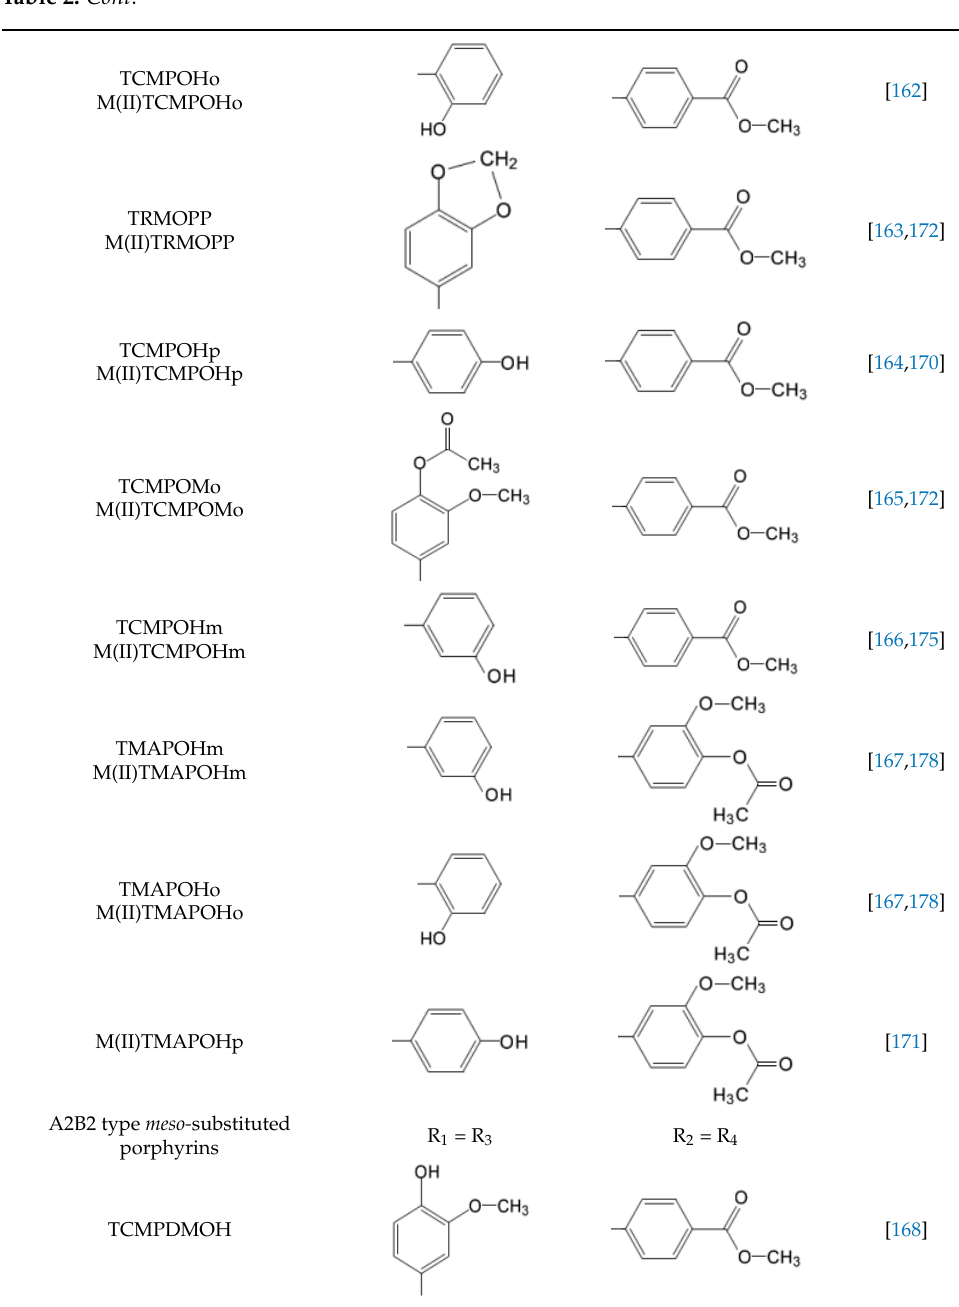
Table 3. Singlet oxygen formation quantum yield ( Φ Δ ), fluorescence emission quantum yield ( Φ F ), and fluorescence lifetime ( τ F ) for a series of tetrapyrrolic compounds (solvent CHCl 3 , except *marked structures were CH 3 OH was used).